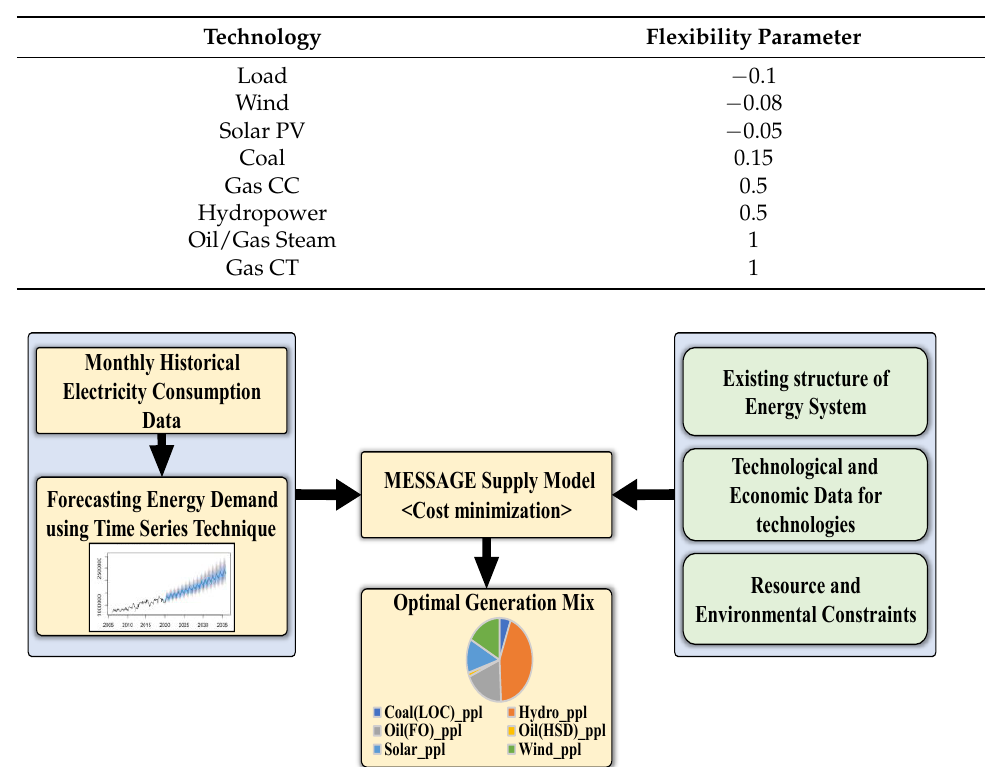
Table 3. Flexibility parameters of technologies from [22].